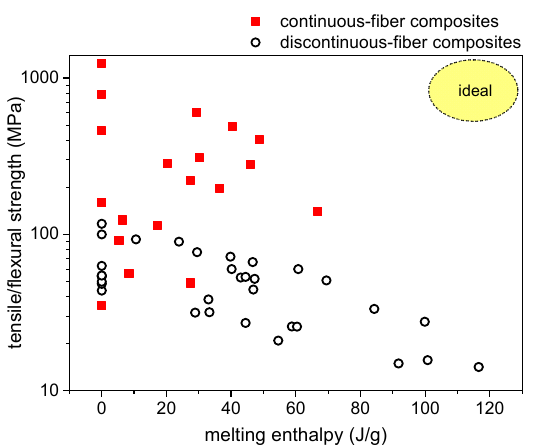
Figure 7. Relationship between mechanical strength (Log scale) and melting enthalpy of all evaluated composites (flexural strength, except for the systems with a PA matrix and the wood/starch/PEG composites, for which the tensile strength is reported). The ideal case is found in the top-right corner, with simultaneous maximization of mechanical strength and melting enthalpy.